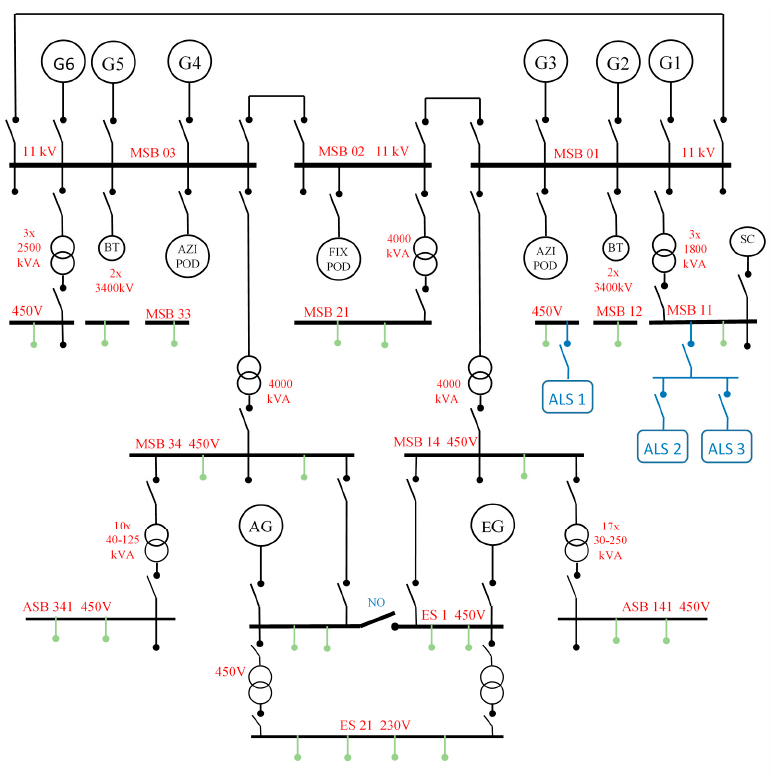
Figure 8. Ae example of simplified diagram of power distribution on a passenger ship with diesel- electric propulsion system.